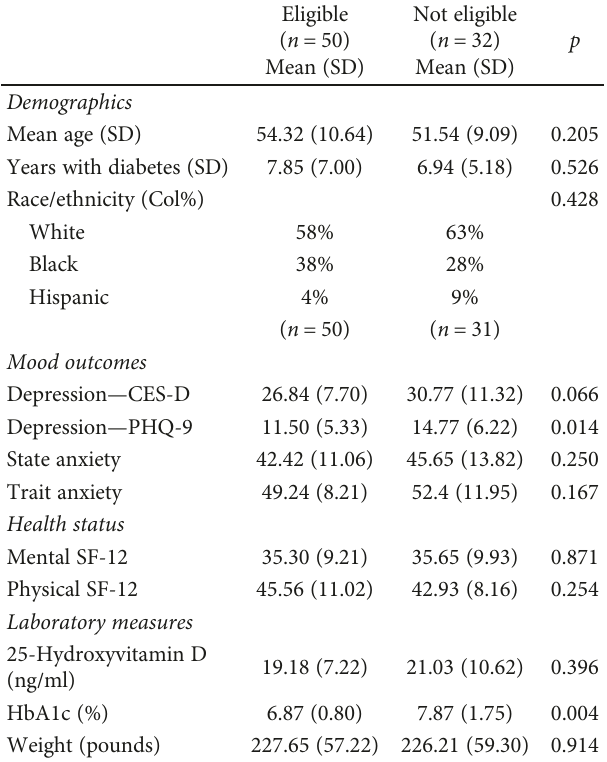
Table 1: Baseline enrollment